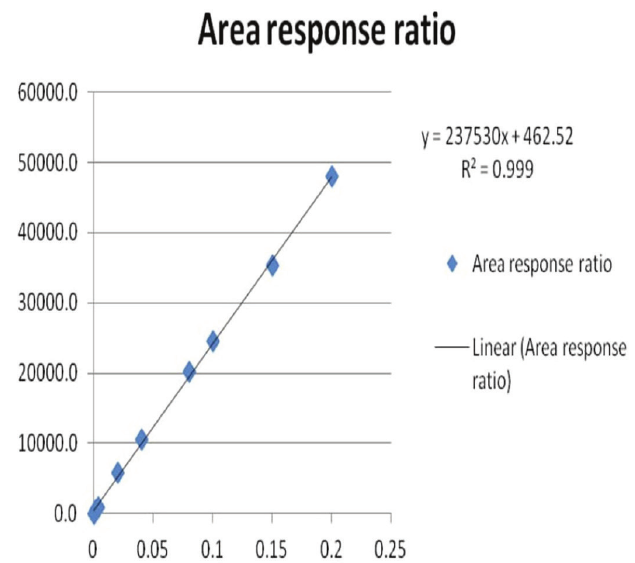
FIGURE 2 - Calibration plot for concentration v/s area